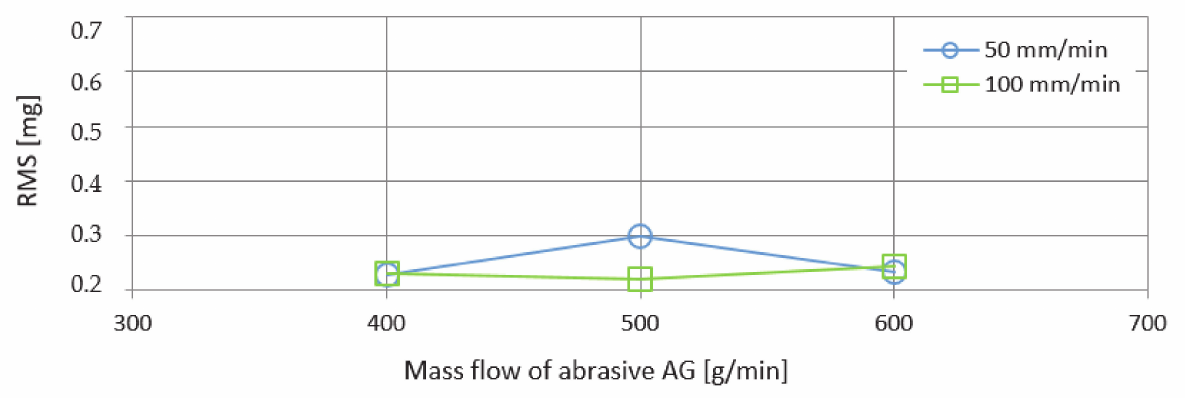
Figure 10. Graphical dependence of RMS on mass flows of abrasive